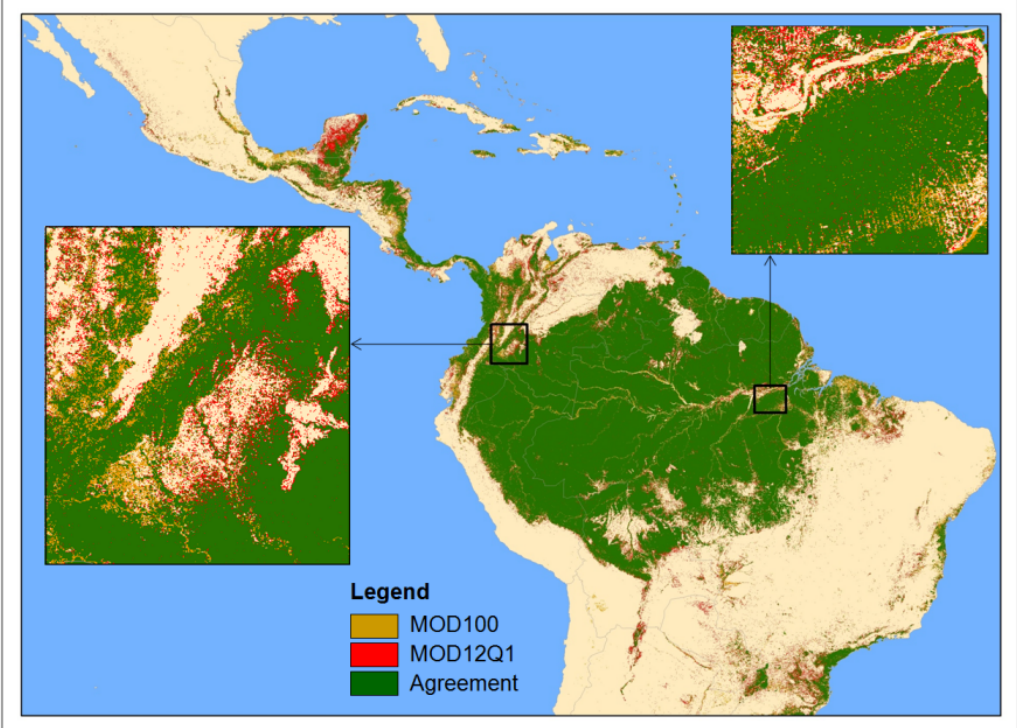
Figure 4. Spatial distribution of evergreen forests in tropical America (30 ° N–30 ° S) in 2001as estimated by the LSWI-based algorithm in this study (MOD100) in comparison to the MOD12Q1 dataset. In the figure legend, “Agreement” – evergreen forest pixels from both MOD100 and MOD12Q1; “MOD100” – evergreen forest pixel from MOD100 only; “MOD12Q1” – evergreen forest pixels from MOD12Q1 only. Two inserts in the figure shows a close-up comparison between these two